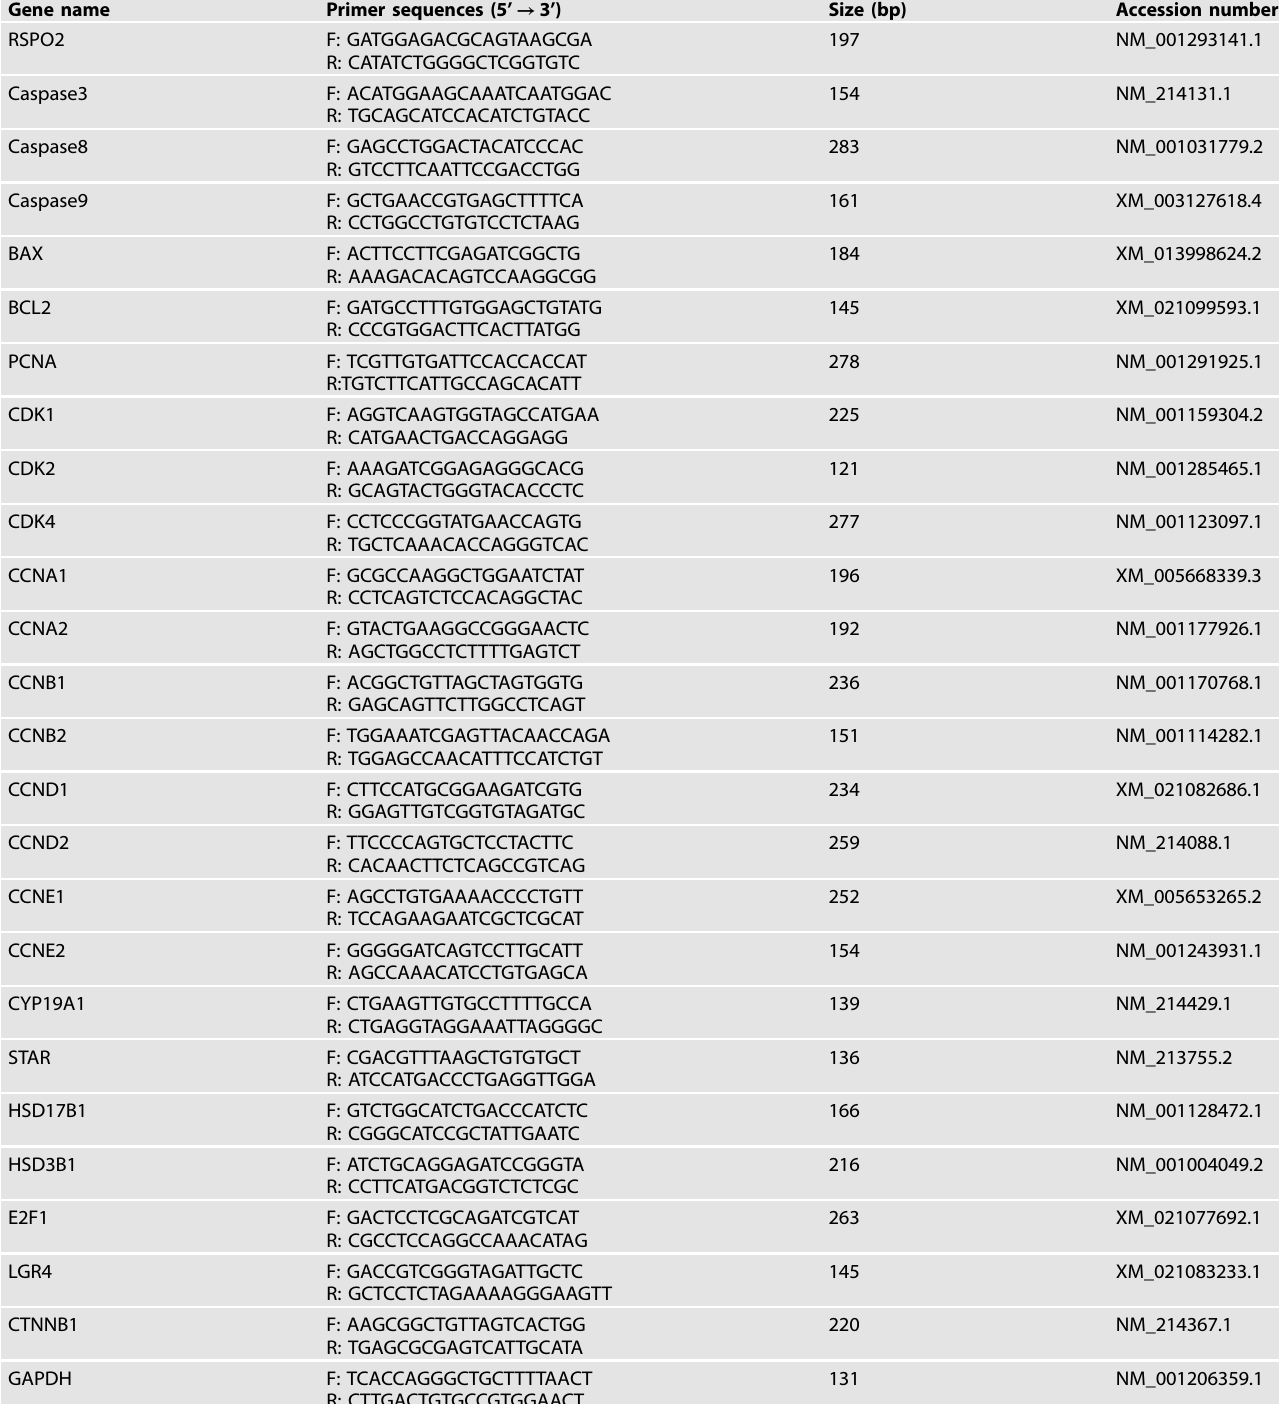
Table 1. Primers used for qRT-PCR in